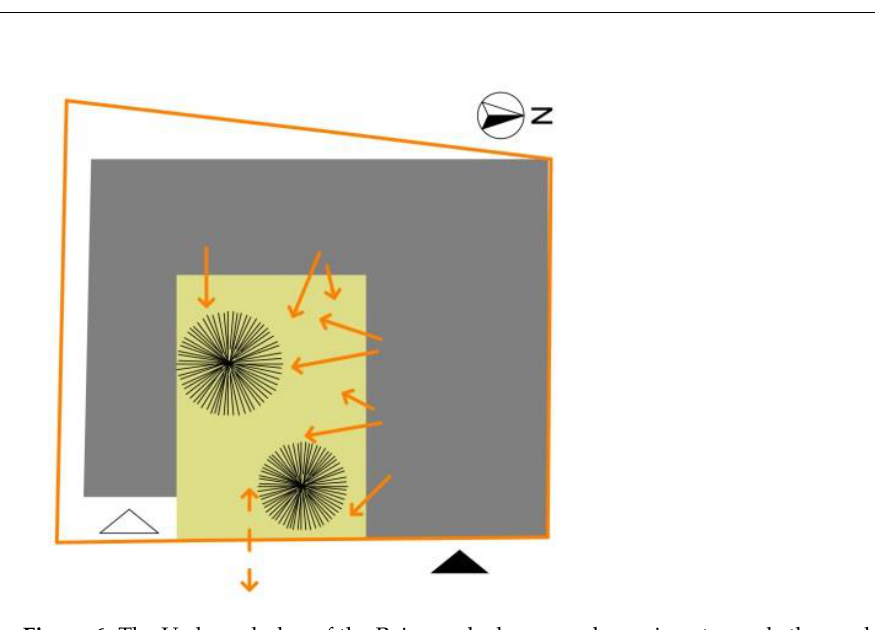
Figure 7. Reinanzaka house of the Raymond family 1924 — detail of the concrete eyebrows and of the ropes for evacuating the rainwater, looking up from the garden. In 1933, the Raymonds decided to build a summer residence (Karuizawa) for them- selves in order to continue developing some of the work in the midst of the hot summer of Tokyo. Raymond had a deep admira tion for Le Corbusier’s oeuvre . In the design of his